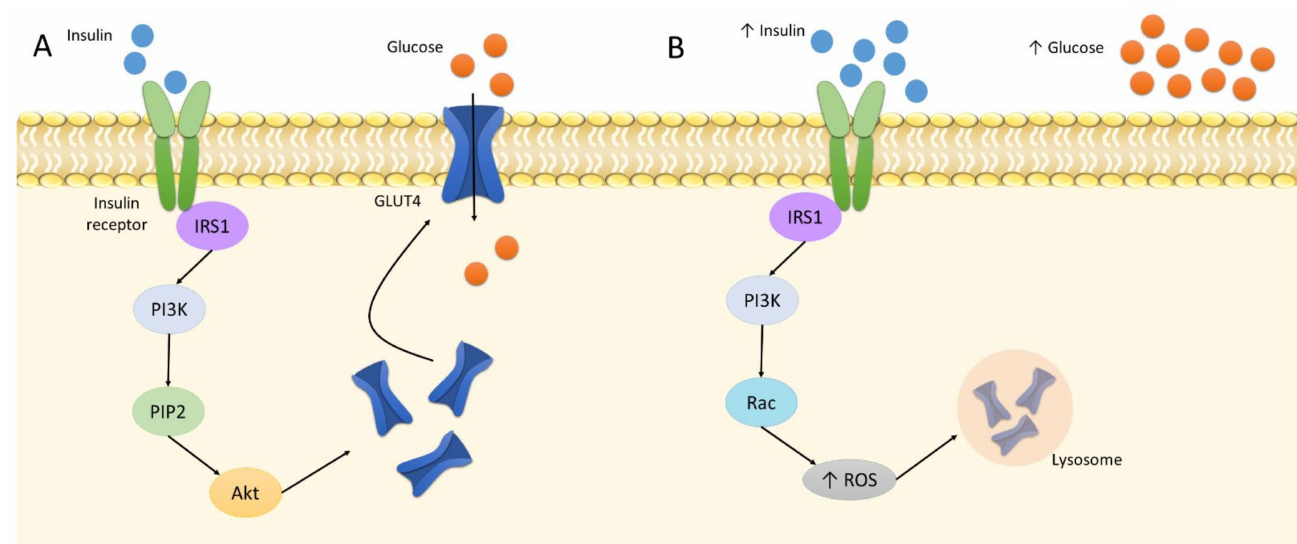
Figure 2. The insulin signaling: A: normal insulin level; B: increased insulin level. Abbreviations: Akt: protein kinase B; IRS1: insulin receptor substrate 1; PI3K: phosphoinositide 3-kinase; PIP2: phosphatidylinositol biphosphate; ROS: reactive oxygen